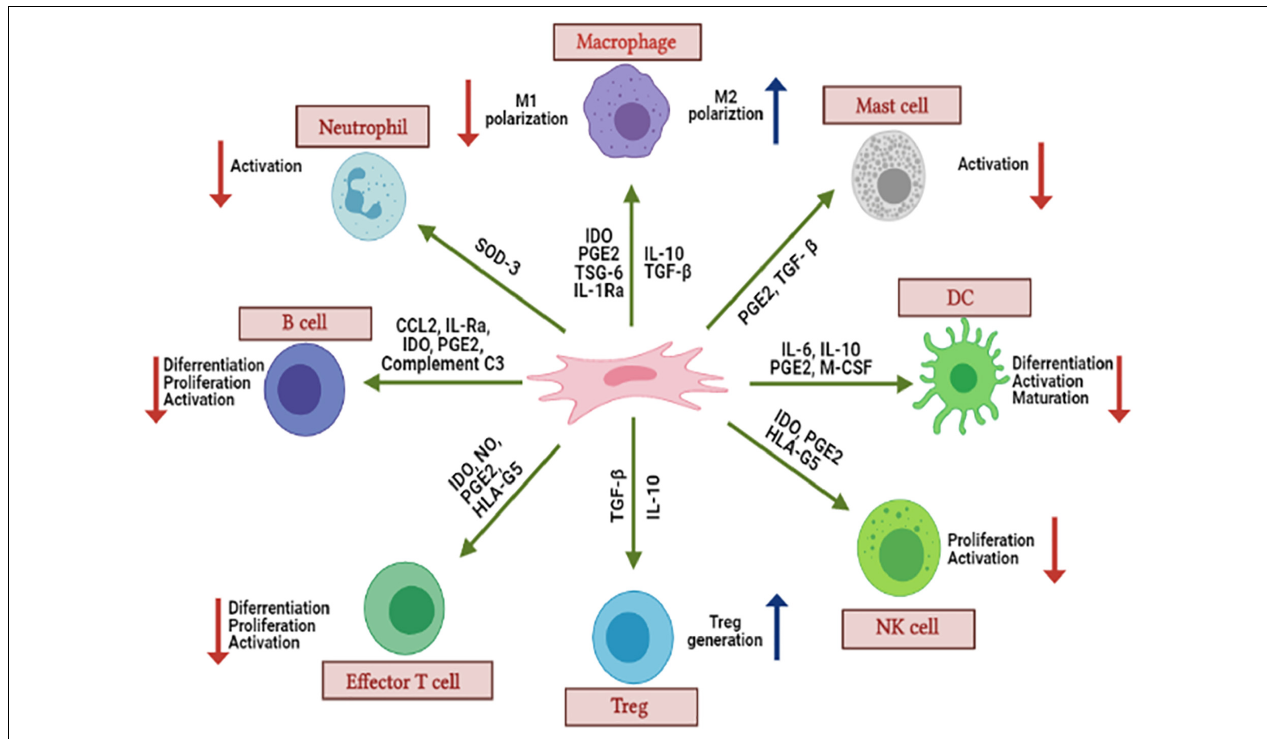
FIGURE 2 | The immunomodulatory effects of MSCs. Various secreted soluble factors (PGE2, TGF- β , HLA-G5, TSG-6, CCL2, IL-1Ra, and IL-10) can activate, suppress, differentiate, and proliferate different immune cell subgroups, including macrophages, mast cells, DC, NK cells, Treg cells, T cells, B cells, and neutrophils. Thus, MCSs will suppress the local inflammation after inhibiting the immune